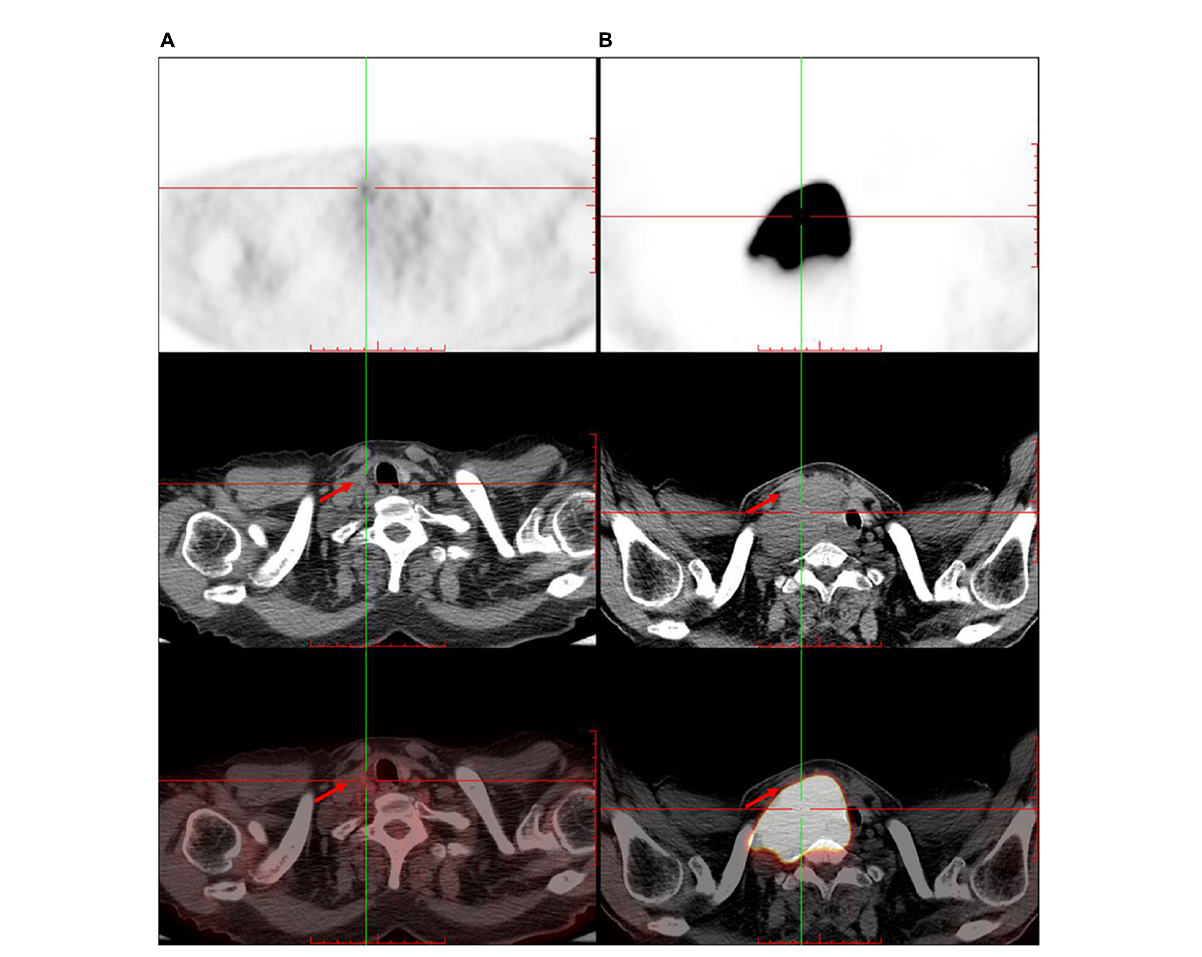
FIGURE3 The trunk positron emission tomography/computed tomography shows significant shrinkage of the original large mass in the right neck after four cycles of immunochemotherapy. (A) After immunochemotherapy for four cycles. (B) Before the immunochemotherapy. Red arrow indicates the